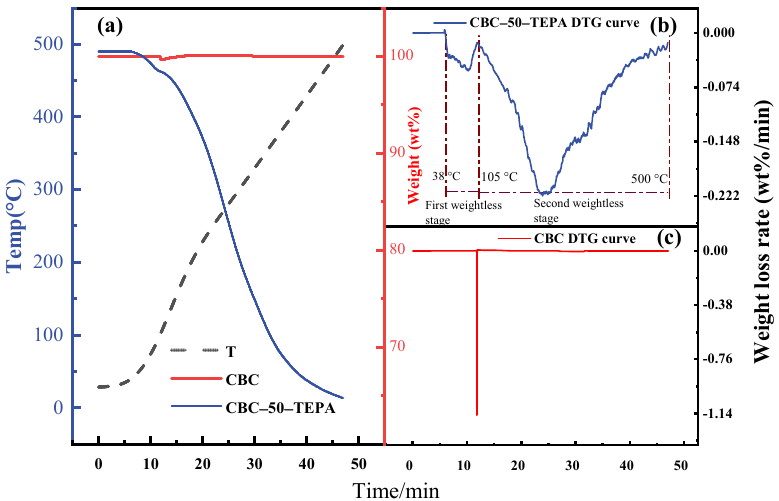
Figure 6. TG curves of weight losses and weight loss rates of pyrolysis and catalytic pyrolysis: ( a ) TGA CBC and CBC-50-TEPA, ( b ) derivative TG (DTG) of CBC-50-TEPA, and ( c ) DTG of CBC.